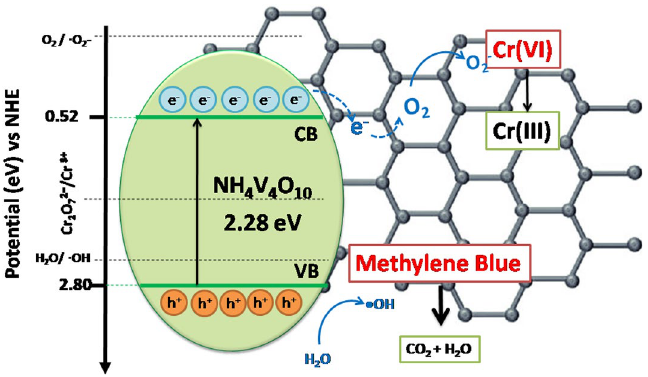
Figure 8. Schematic diagram of the band-energy levels of NVO/rGO with the possible photocatalytic